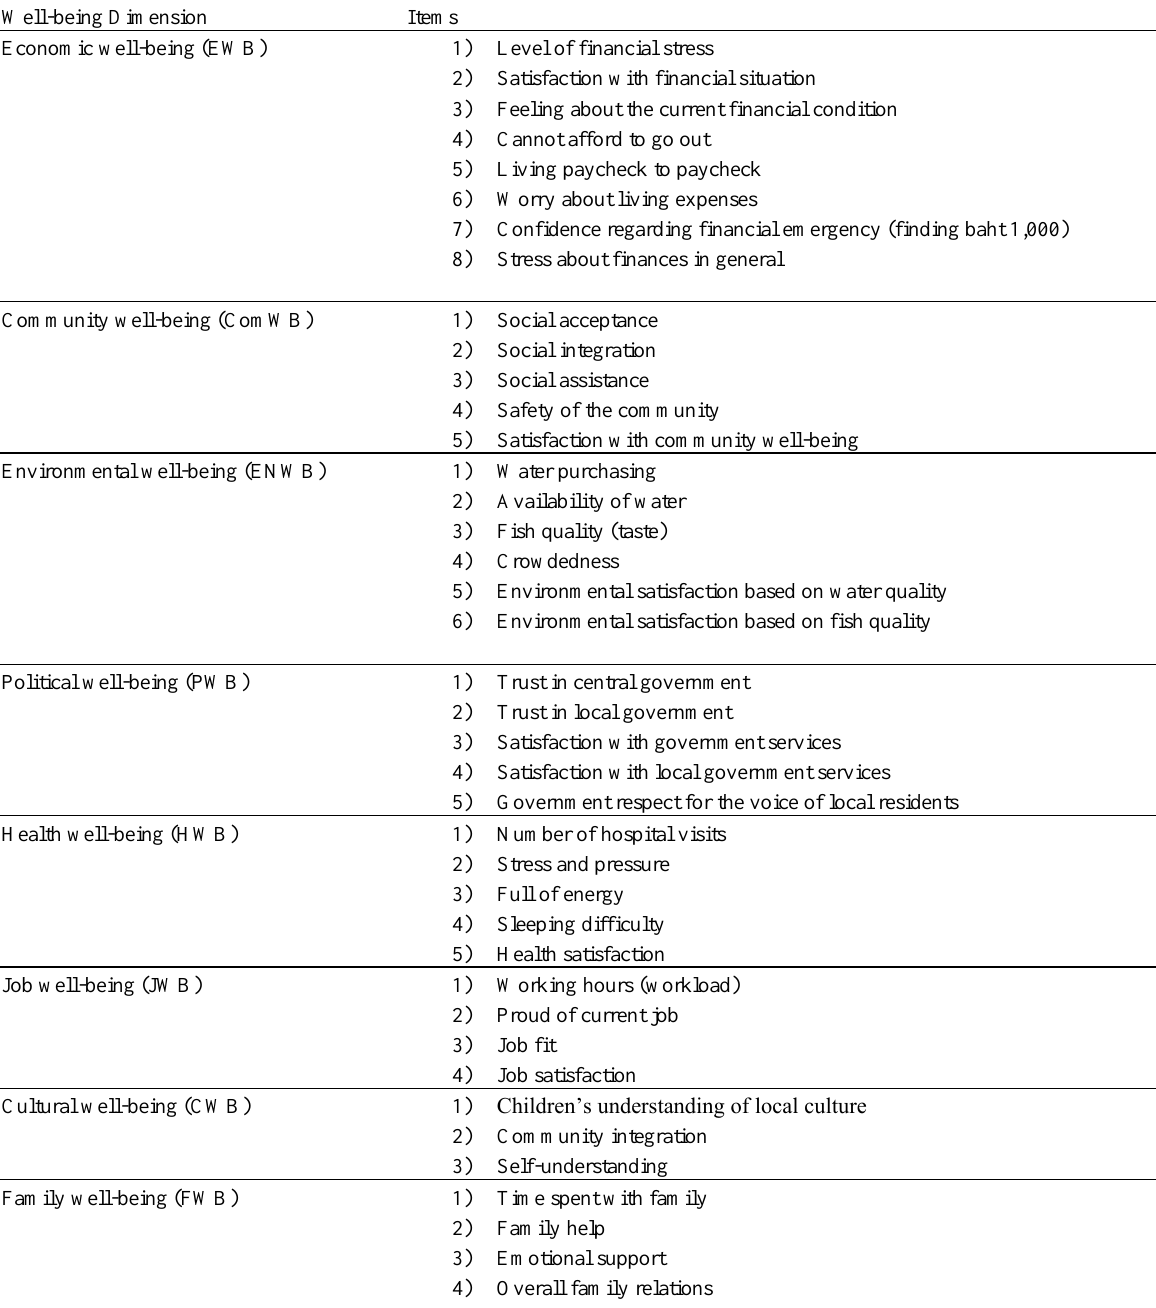
Table 1: Well-being dimensions with their items(Chaiyamart, 2021) Well-being